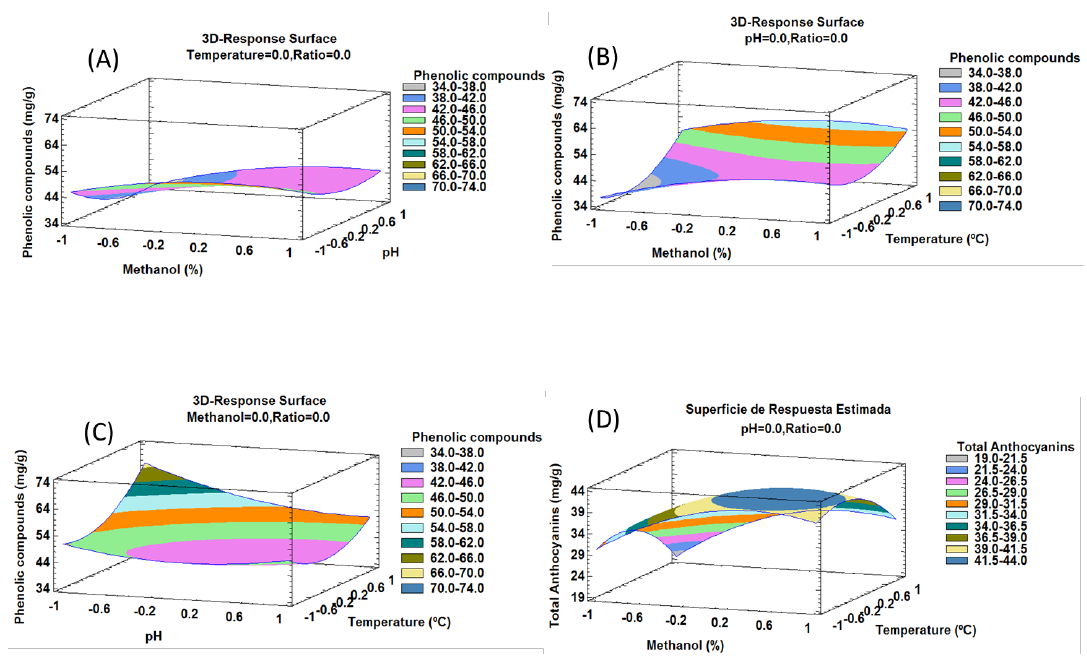
Figure 3. Three-dimensional response surface plots for the graphical representation of the influence